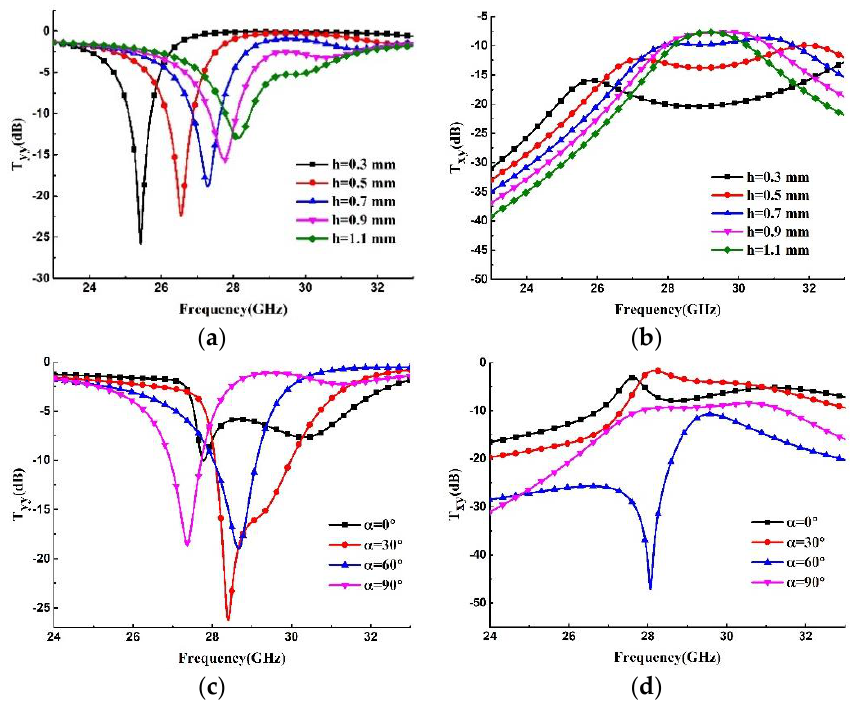
Figure 2. ( a ) Simulated co- and ( b ) cross-polarization transmission curves varying with the thickness h. ( c ) Simulated co- and ( d ) cross-polarization transmission curves varying with the twisted angle α.